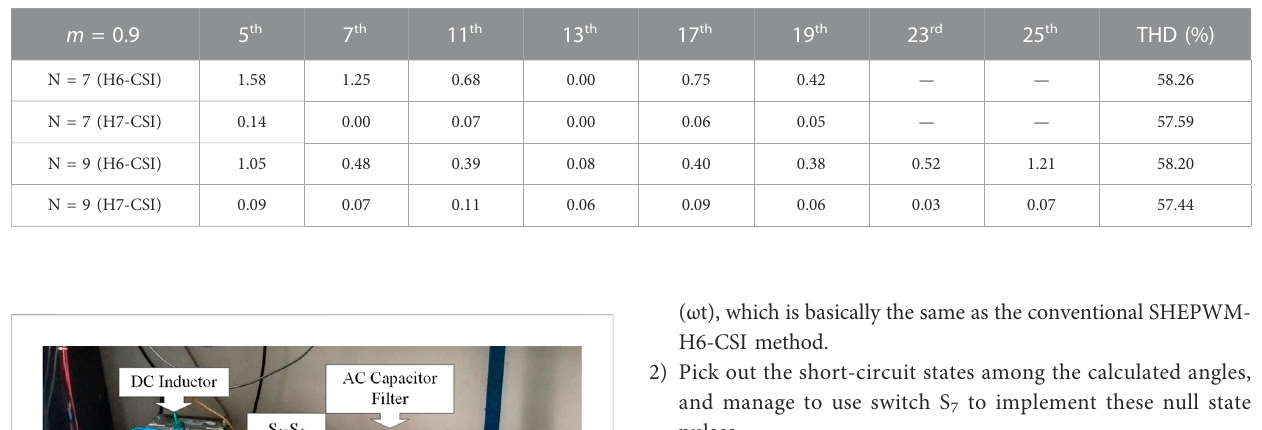
TABLE 3 Harmonic performance (% of fundamental).